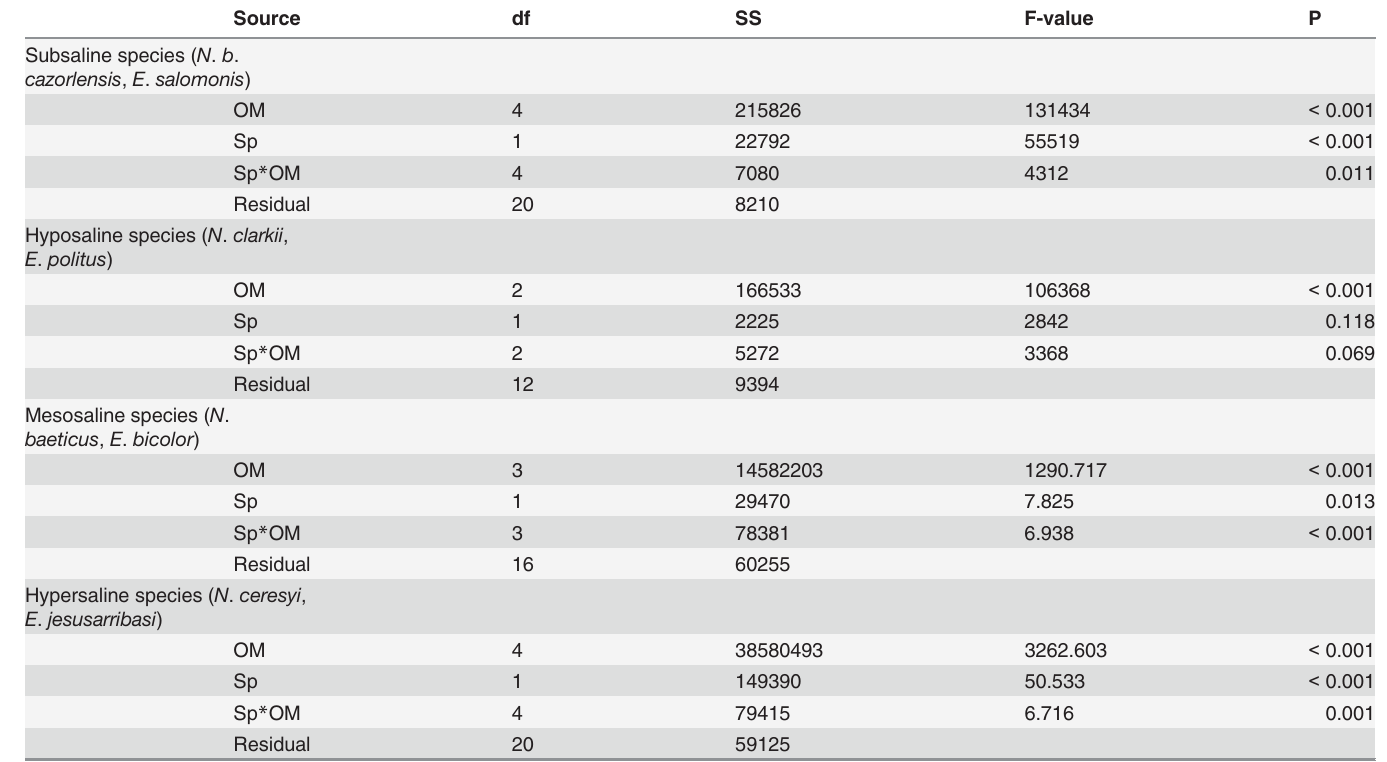
Table 3. Effect of osmotality of external medium (OM), species (Sp) and their interaction on osmotic capacity